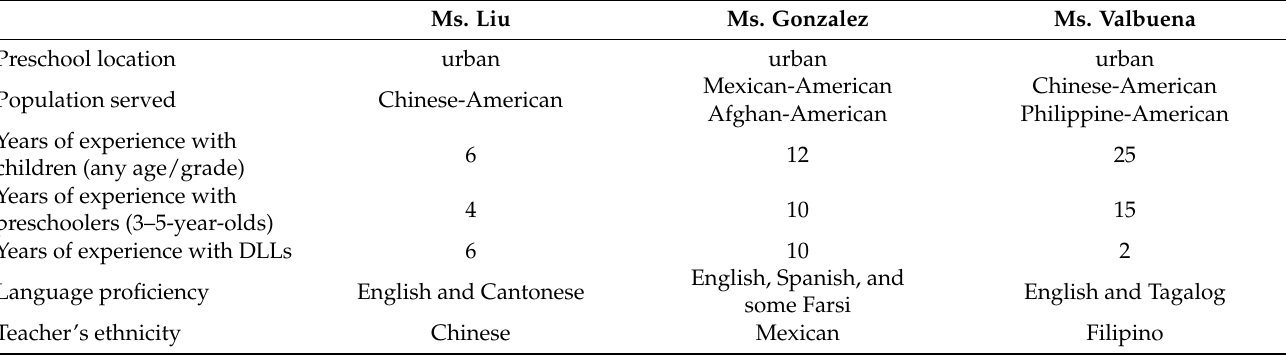
Table 2. Characteristics of the teachers participating in the interviews ( N =